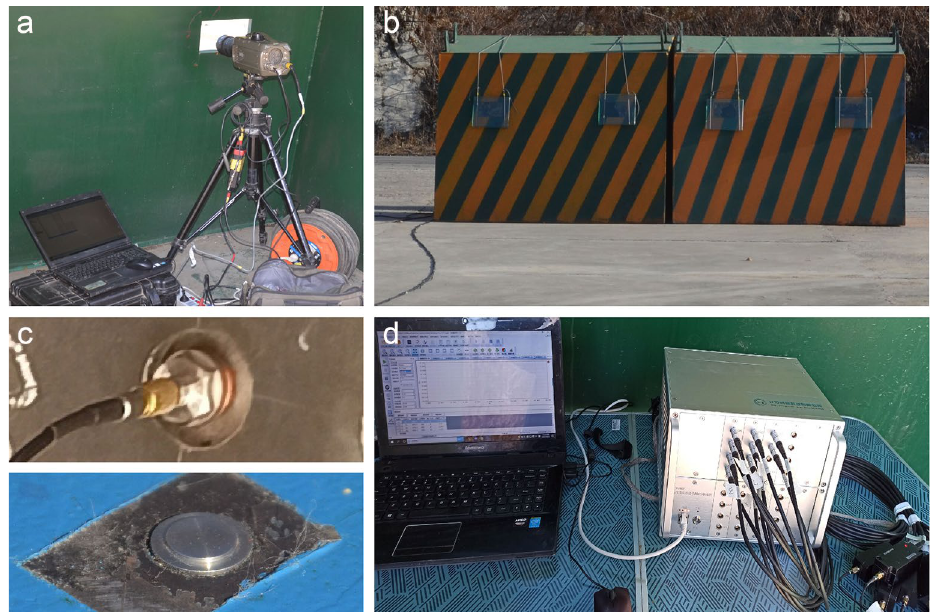
Figure 8. Test methods. ( a ) High-speed camera. ( b ) Bunkers with glass windows. ( c ) Gauges inside and outside the shell. ( d ) Charge debugger, dynamic data acquisition, and processing